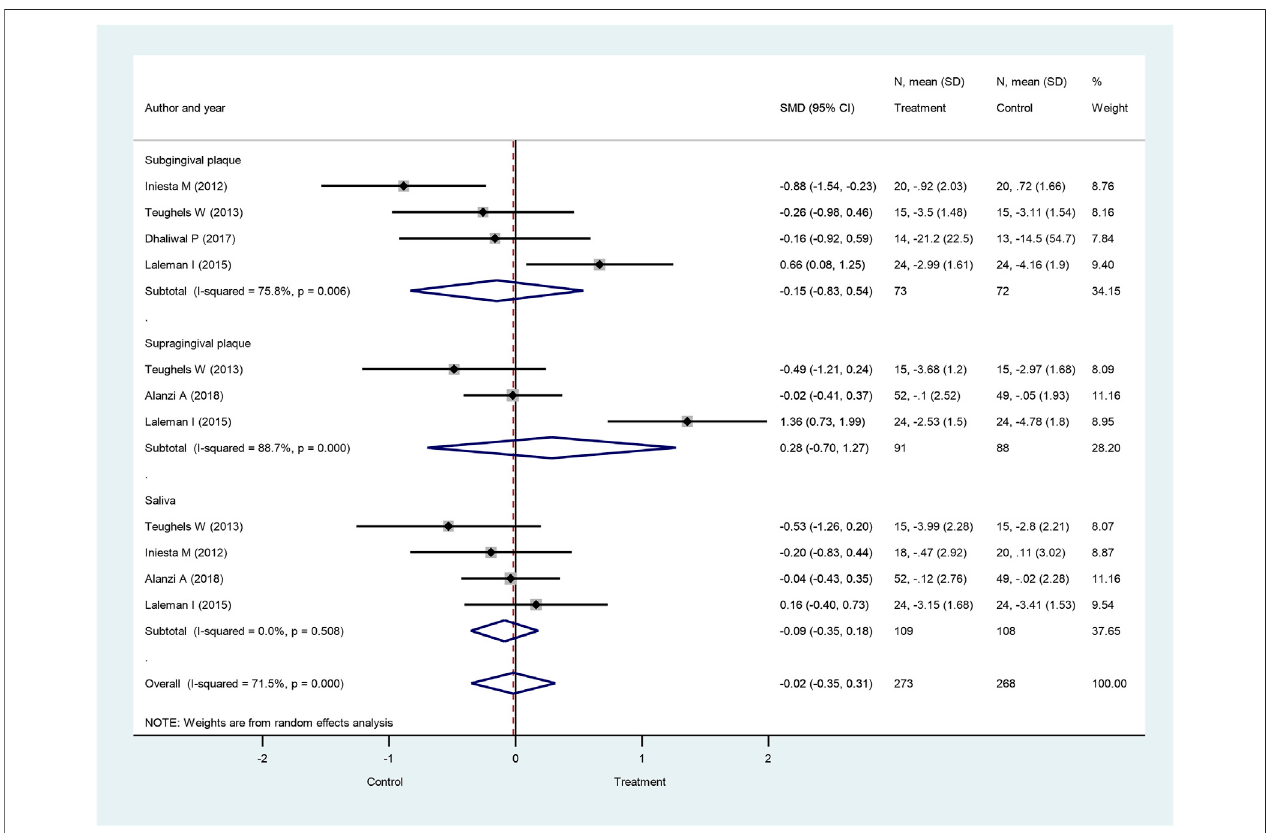
FIGURE 5 | Forest plot analysis of the change in Porphyromonas gingivalis at 4 weeks. The overall result presented no signi fi cant difference of bacterial decrease when both treatment and control groups were compared (SMD: − 0.02; 95% CI: − 0.35 – 0.31; p (cid:2) 0.914).